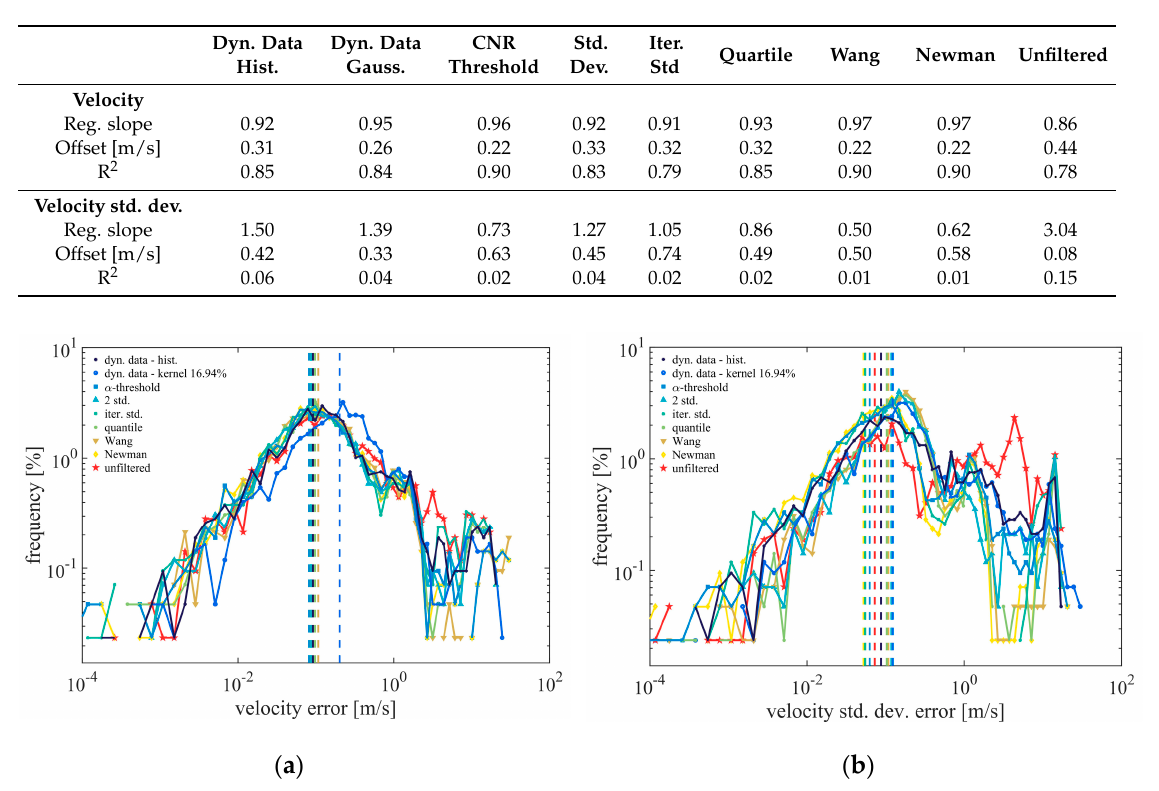
Figure 14. Histogram in double logarithmic scaling with exponential increasing bin width of the ( a ) absolute average velocity error and ( b ) the absolute velocity standard deviation error. Vertical dashed lines indicate the centre of a fitted Gaussian curve.